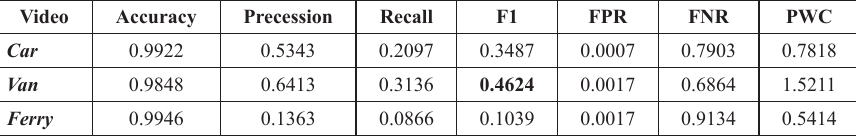
Table 9. Performance metrics results of applying Fuzzy Sugeno Integral model